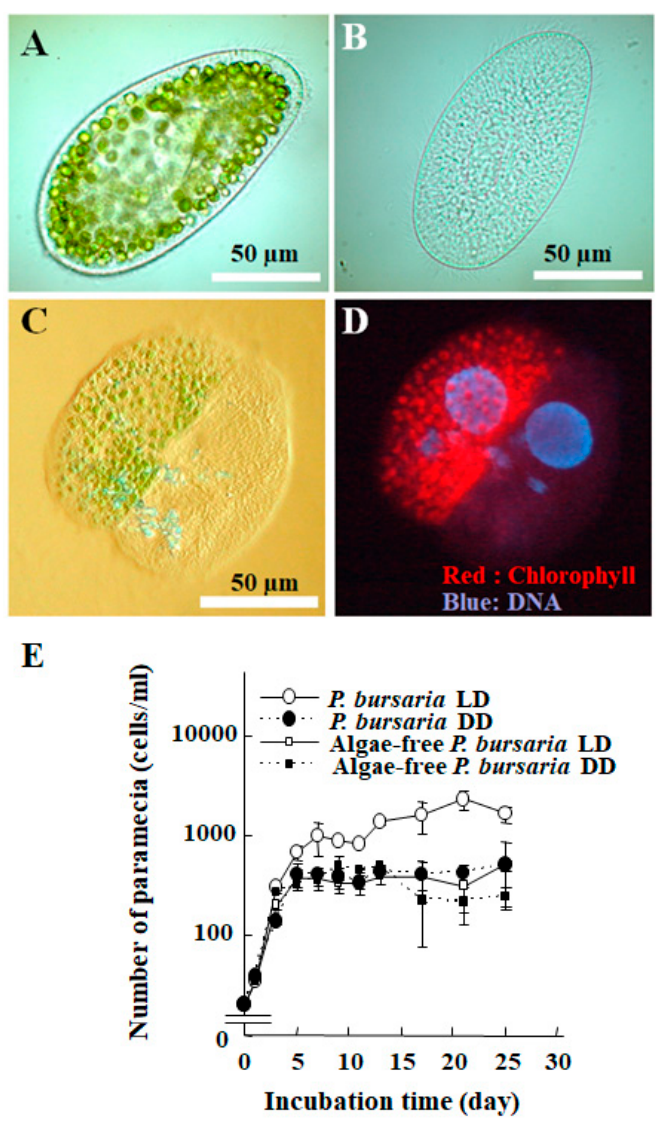
Figure 1. P. bursaria in a natural state and several experimental states. Photographs show P. bursaria with endosymbiotic algae in a natural state ( A ) and algae-free Paramecium ( B ) produced by treatment of P. bursaria with paraquat herbicide. Photographs (( C ) a bright field image and ( D ) the corresponding fluorescence image) show sexual conjugation of native P. bursaria with an algae-free strain of P. bursaria produced by exposure of a human neurotoxin acrylamide to P. bursaria . Red and blue fluorescence in the panel D respectively derive from endogenous chlorophyll of endosymbiotic algae and from DAPI-staining Paramecium nuclei. Here, panels A–D were referred from the literature [7]. ( E ) The graph depicts growth kinetics of algae-bearing P. bursaria cultured under an LD cycle (12 h light/12 h dark) (white circle), that under DD (constant dark) (black circle), algae-free P. bursaria under a LD cycle (white square), and alga-free cells under DD (black square) in media containing bait bacteria. The numbers of paramecia (average ± S.D.) are shown over time.